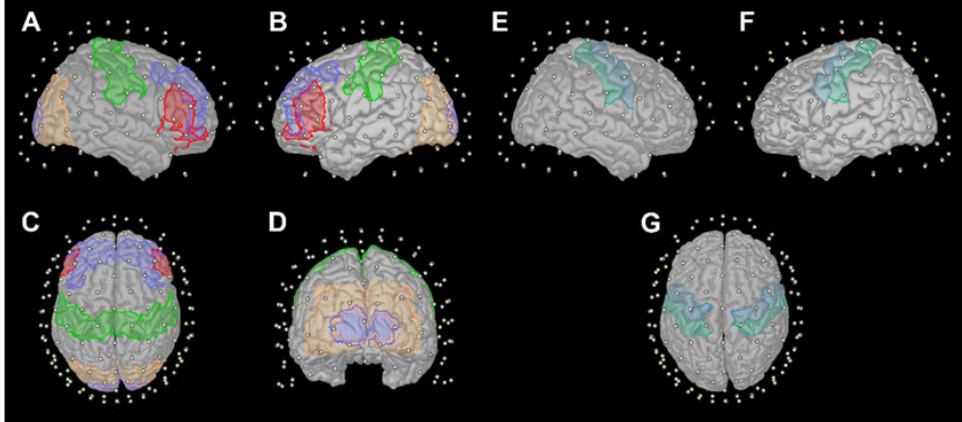
Figure 2. ( A – D ) Cortical parcellations according to Brodmann areas on Colin27 atlas: BA1-2-3-4 (green), BA17 (light violet), BA18-19 (orange), BA45-47 (red), and BA46-9 (dark violet). ( E – G ) Cortical parcellations according to Destrieux on Colin27 atlas: precentral gyrus (dark blue) and postcentral gyrus (light blue). White dots indicate channel positions over scalp surface. Table 2. Summary of employed left (L ‐ ) and right (R ‐ ) hemisphere areas and their correspondence between Brodmann areas and anatomical areas.